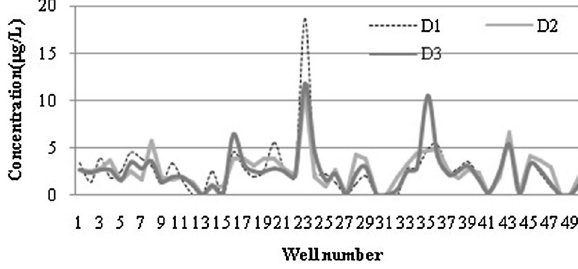
Fig. 4 Arsenic Content ( l g/L) of the shallow wells in the dry seasons ( D1 , D2 and D3 ) Table 2 Distribution of shallow wells in different range of As content Arsenic range No. of shallow